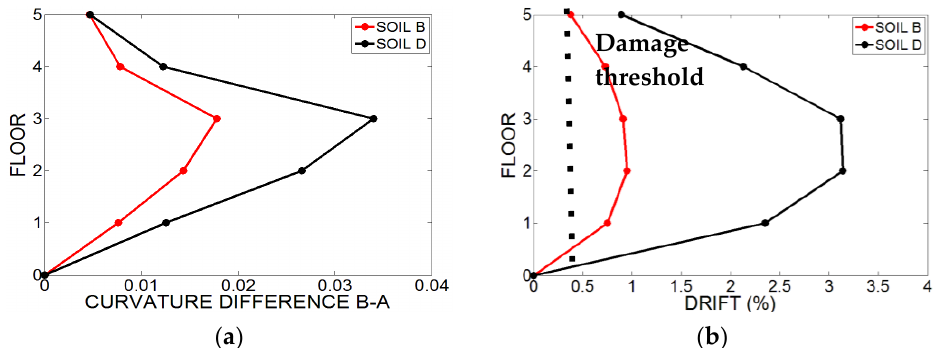
Figure 13. Structural damage localization for the numerical models. Results of the 5-story irregular in plan structure: ( a ) curvature difference between the selected time-instants B and A; ( b ) inter-story drift and damage threshold equal to 0.5% (for non-structural components) valid for reinforced concrete framed structures. Table 2. Performance level definition as a function of inter-story drift [50].